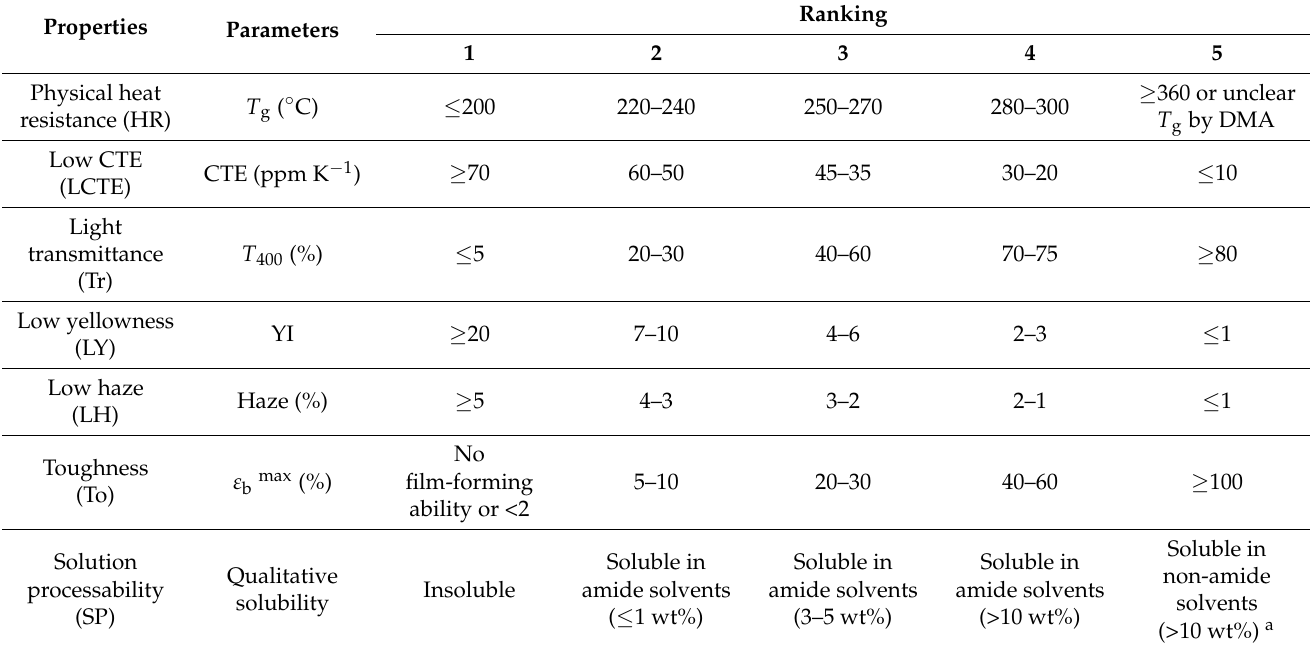
Figure 14. Key factors influencing the generation of low CTEs during solution casting and their interrelations. Table 5. Criteria for ranking the achievement level of each target